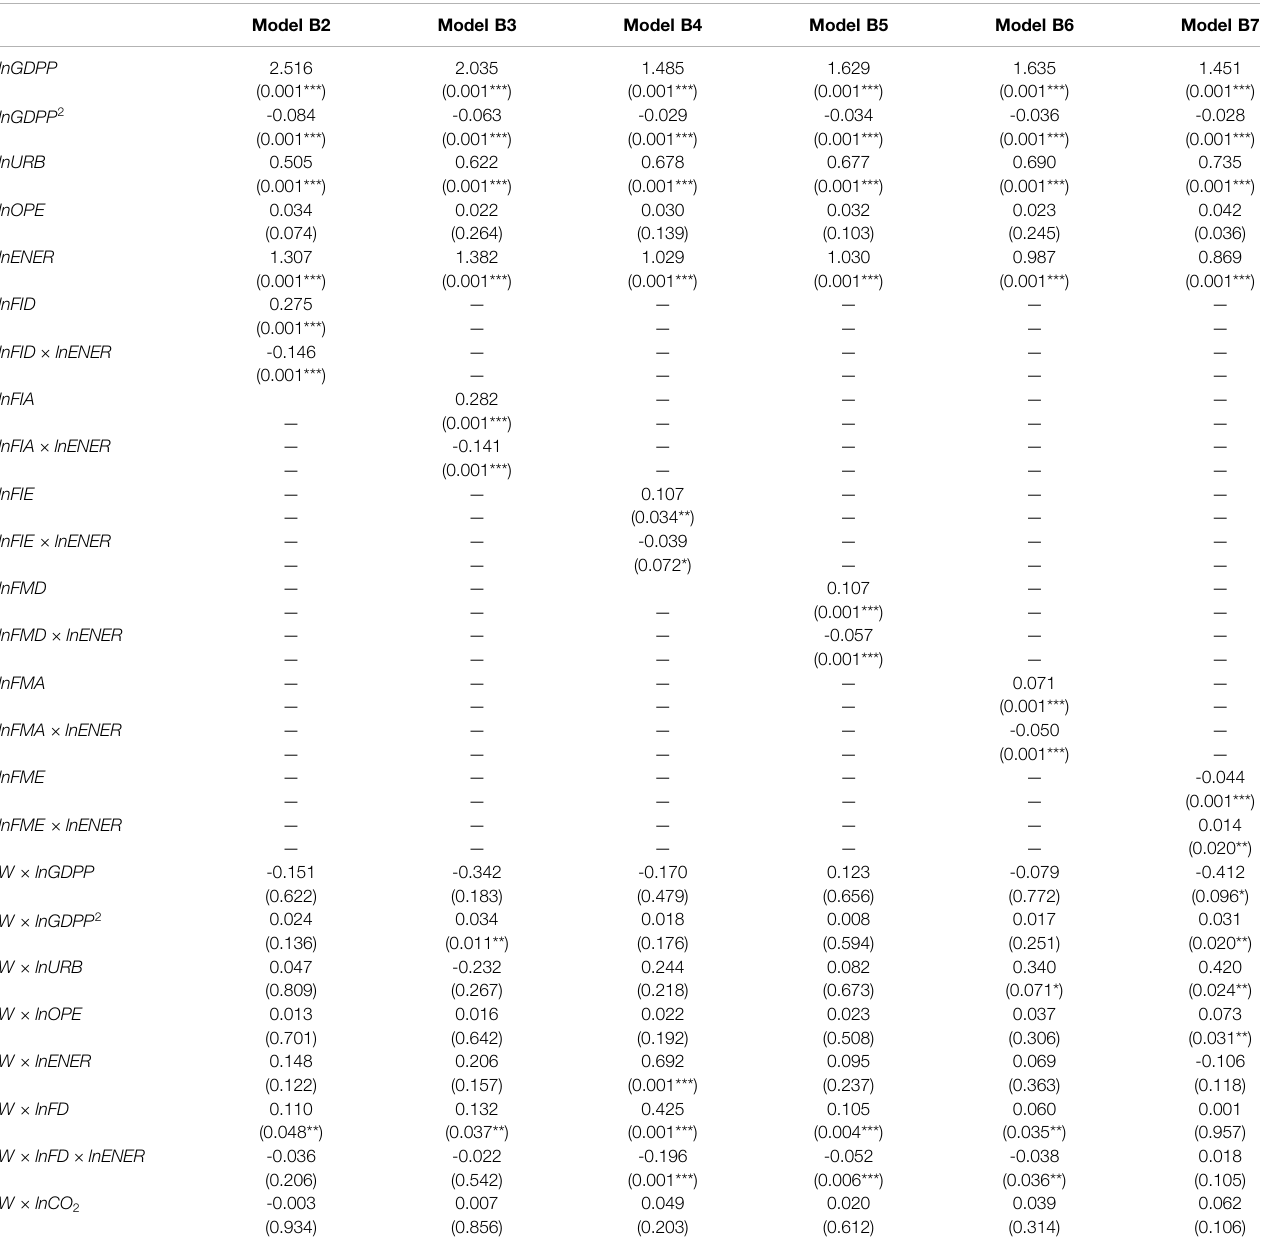
TABLE 10 | Eq. 2 ’ s estimated